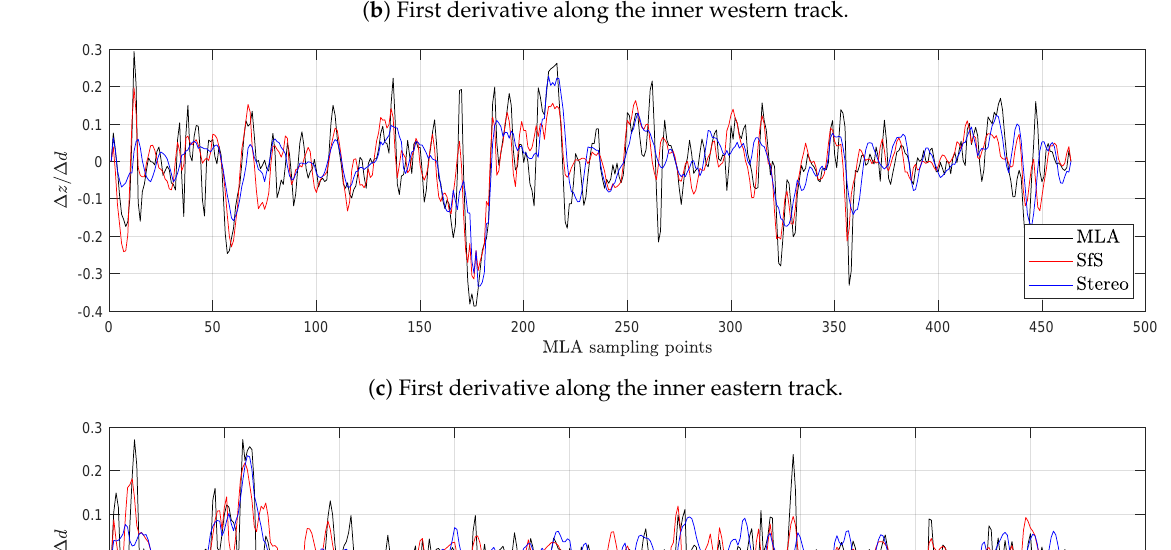
( b ) First derivative along the inner western track.